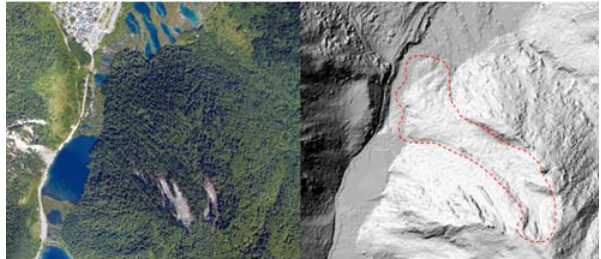
Figure5. Airborne Lidar Data for Geohazards Identification (Technology Innovation Center of Emergency Surveying and Mapping, 2019)